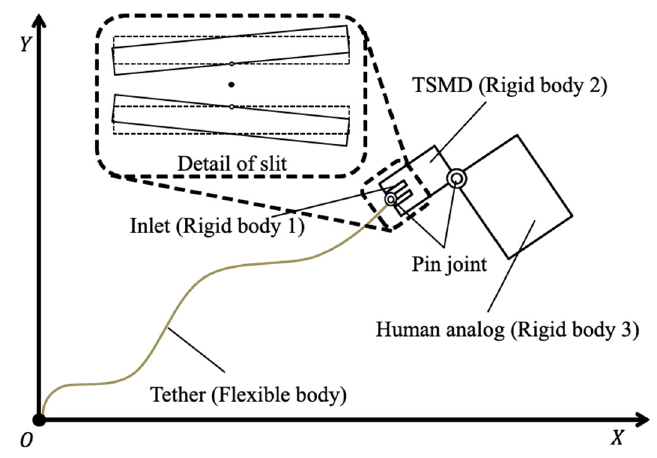
Figure 2. Outline of analytical model.